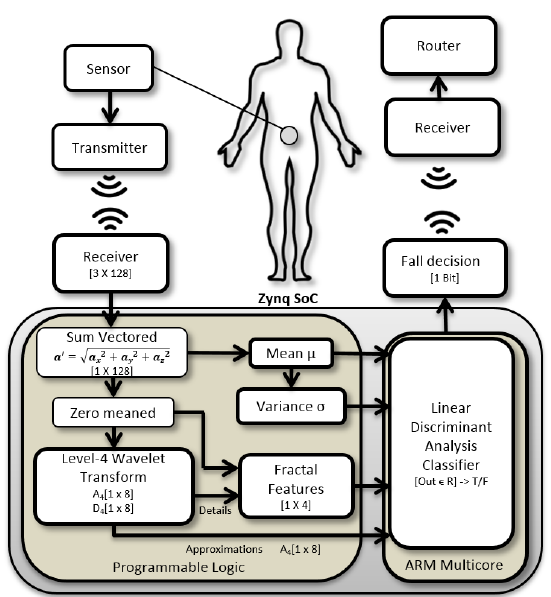
Figure 1. Wearable fall detection system